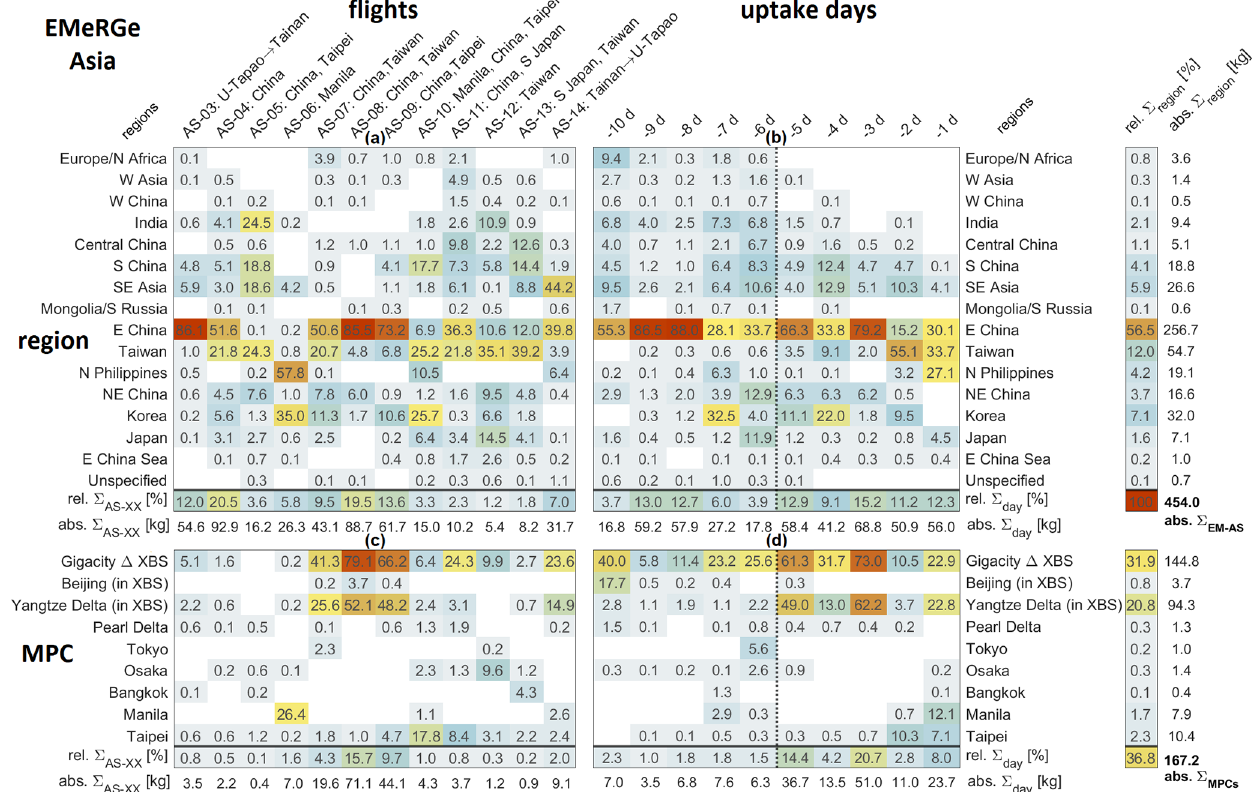
Figure 8. Absolute and relative CO contribution potentials of 15 source regions and nine MPCs (listed in Table 4) during EMeRGe-Asia. Absolute values (uncoloured rows) give the sum of contribution potentials for single flights (abs. (cid:80) AS − XX ), uptake days (abs. (cid:80) day ), as well as for source regions and MPCs (abs. (cid:80) region ). For EMeRGe-Asia, the total uptake sum is 454.0kg (abs. (cid:80) EM-AS ) and for the selected MPCs 167.2kg (abs. (cid:80) MPC ). Small deviations between absolute value sums and the total uptake sum are caused by rounding. Relative contribution potentials (colour-coded) of individual source regions are separated into contributing emission uptakes per flight (a, c) , normalised to the absolute uptake sum per flight (region AS-XX /abs. (cid:80) AS-XX ), as well as separated into contributing emissions for the 10 particular uptake days prior to sampling with HALO (b, d) , normalised to the absolute uptake sum per uptake day (region day /abs. (cid:80) day ). Relative uptake sums rel. (cid:80) x are normalised to the total uptake sum (rel. (cid:80) x = abs. (cid:80) x / (cid:80) EM-AS , with x = AS-XX, day and region). Target regions are given in the column label after flight labels. Regions are sorted by location from west (top) to east (bottom). Unspecified includes all areas outside the selected regions. XBS –